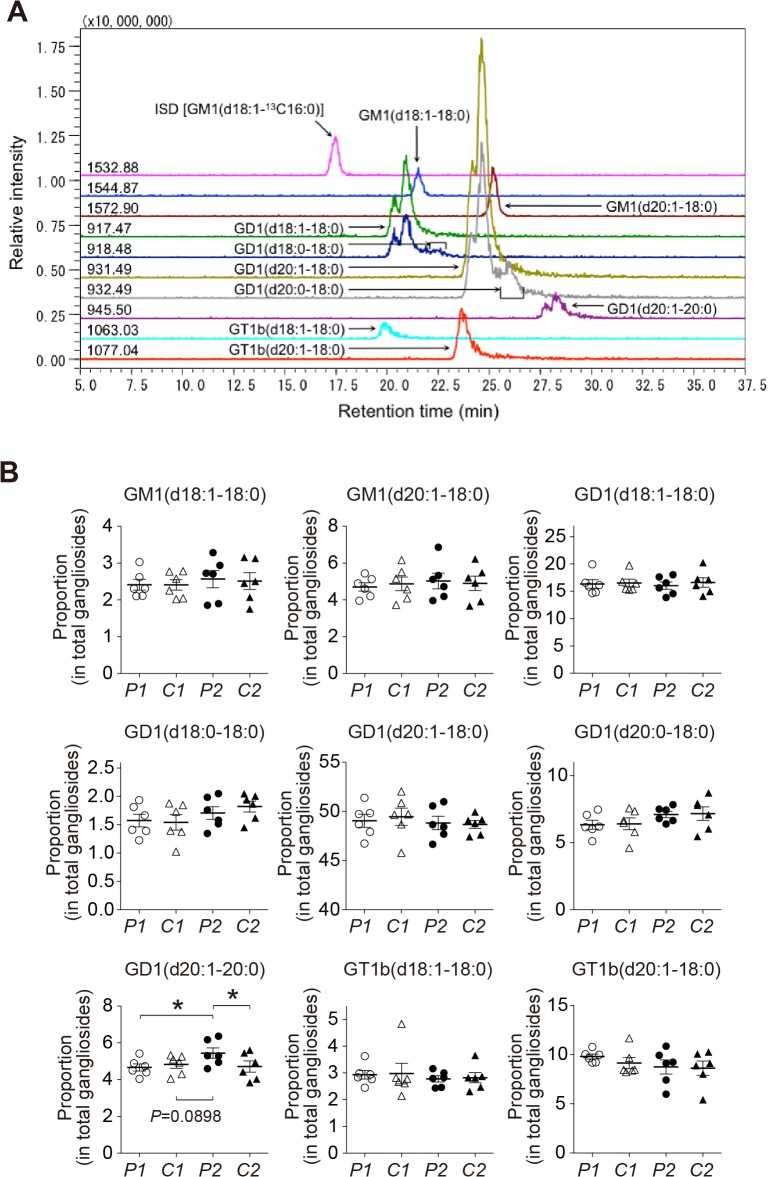
Increased proportion of GD1(d20:1–20:0) ganglioside species in the amyloid-bearing precuneus.A, Representative chromatograms of reverse-phase LC-MS of gangliosides using a C30 column. GM1(d18:1–13C16:0) [m/z 1532.88 (shown on the left side on the chromatogram)] was used as the internal standard (ISD). Ganglioside species containing diverse ceramide structures, such as d18:1 or d20:1 in the sphingoid base and 18:0 or 20:0 in the fatty acid chain, were separately detected in this system. The expression level of each ganglioside species was calculated by measuring each peak area above the baseline. B, Composition of gangliosides of SPMs. Gangliosides in the lipid samples extracted from SPMs were analyzed by reverse-phase LC-MS as indicated A. The proportion of each ganglioside species containing diverse ceramide structures in the detected gangliosides is expressed as mean ± SEM. *, p<0.05. P1, C1, P2 and C2 indicate lipid samples extracted from SPMs of the amyloid-free precuneus, the calcarine cortex of the brain with the amyloid-free precuneus, the amyloid-bearing precuneus, and the calcarine cortex of the brain with the amyloid-bearing precuneus, respectively.